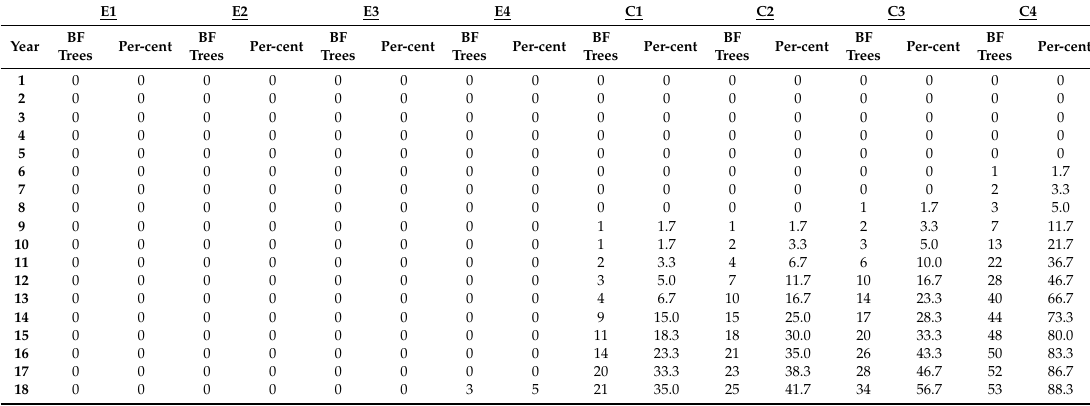
Table 4. Development of NBF over an 18-year evaluation period for Nonpareil REO source-clones E1–E4 compared with standard commercial sources C1–C4. (Sixty trees of each clone-source were